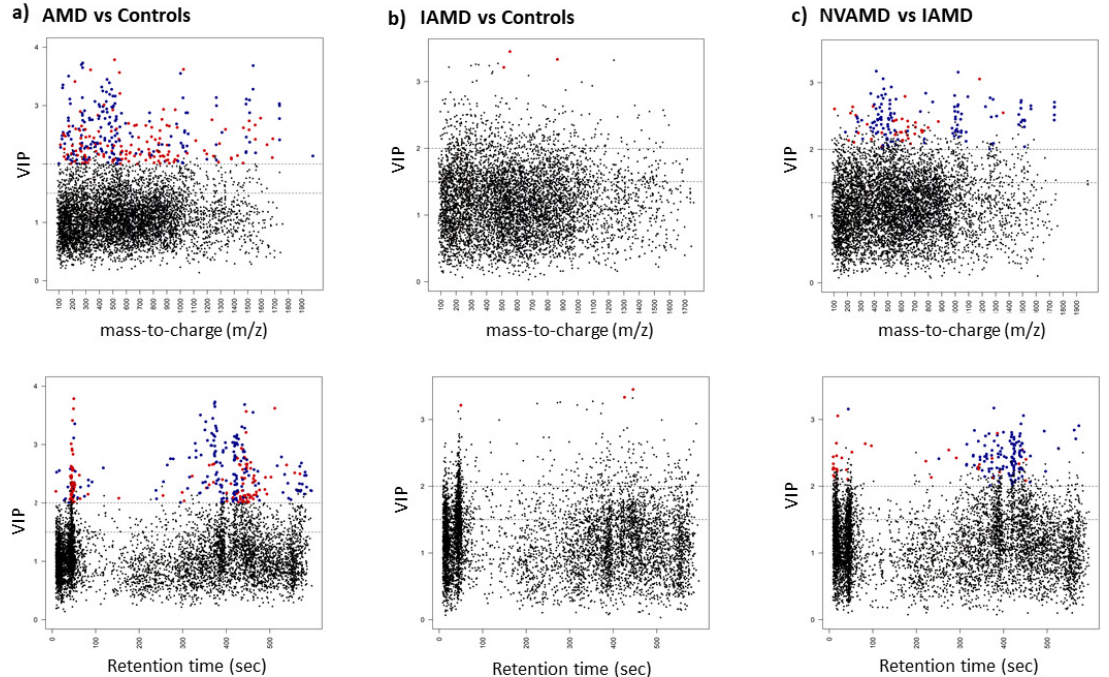
Figure 1. Discriminatory features identified by PLS-DA and linear regression analyses. Manhattan plots displaying significant discriminatory features (PLS-DA VIP ≥ 2 and linear regression FDR < 0.1 ( p < 0.05)) that were higher (blue dots) or lower (red dots) in the plasma of ( a ) AMD patients compared to controls, ( b ) IAMD patients compared to controls, and ( c ) NVAMD patients compared to IAMD patients. Black dots indicate features that did not meet significance criteria. There are two plots for each comparison—VIP by m/z and VIP by Retention time (sec). AMD: age-related macular degeneration; IAMD: intermediate AMD; NVAMD: neovascular AMD; PLS-DA: partial least-squares discriminant analysis; VIP: variable importance for projection.